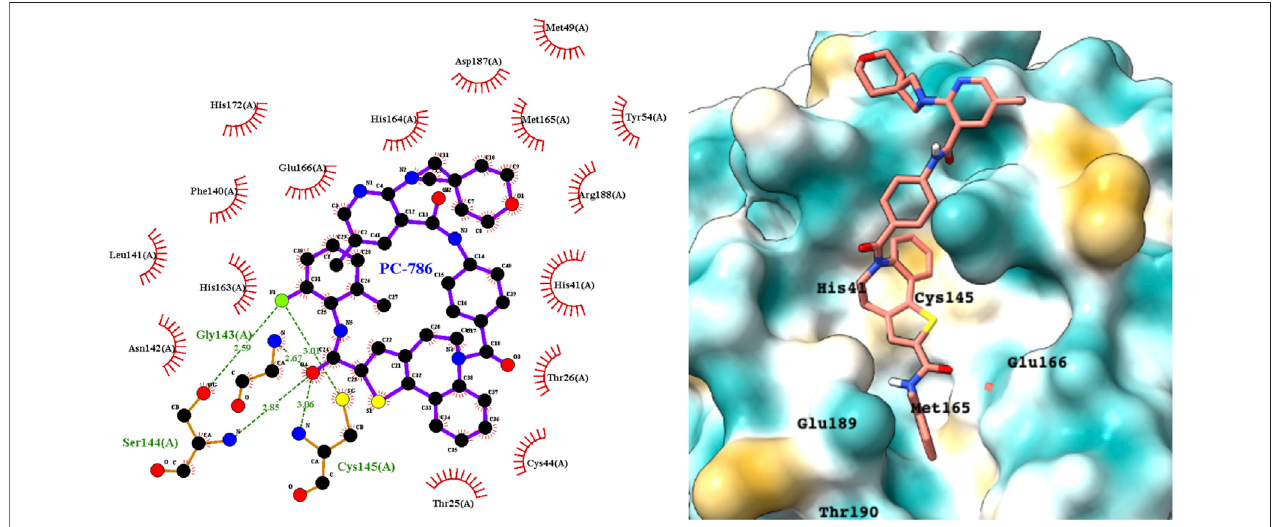
FIGURE 5 | LigPlot (left) and hydrophobic protein surface representation (right) of the main interactions between M pro and PC786. The molecular surface denotes hydrophobicity of the pockets (blue hydrophilic, yellow/brown hydrophobic). Key binding site residues are labeled to help orient the viewer. Other novel putative M pro inhibitors from the short list of 84 drugs.